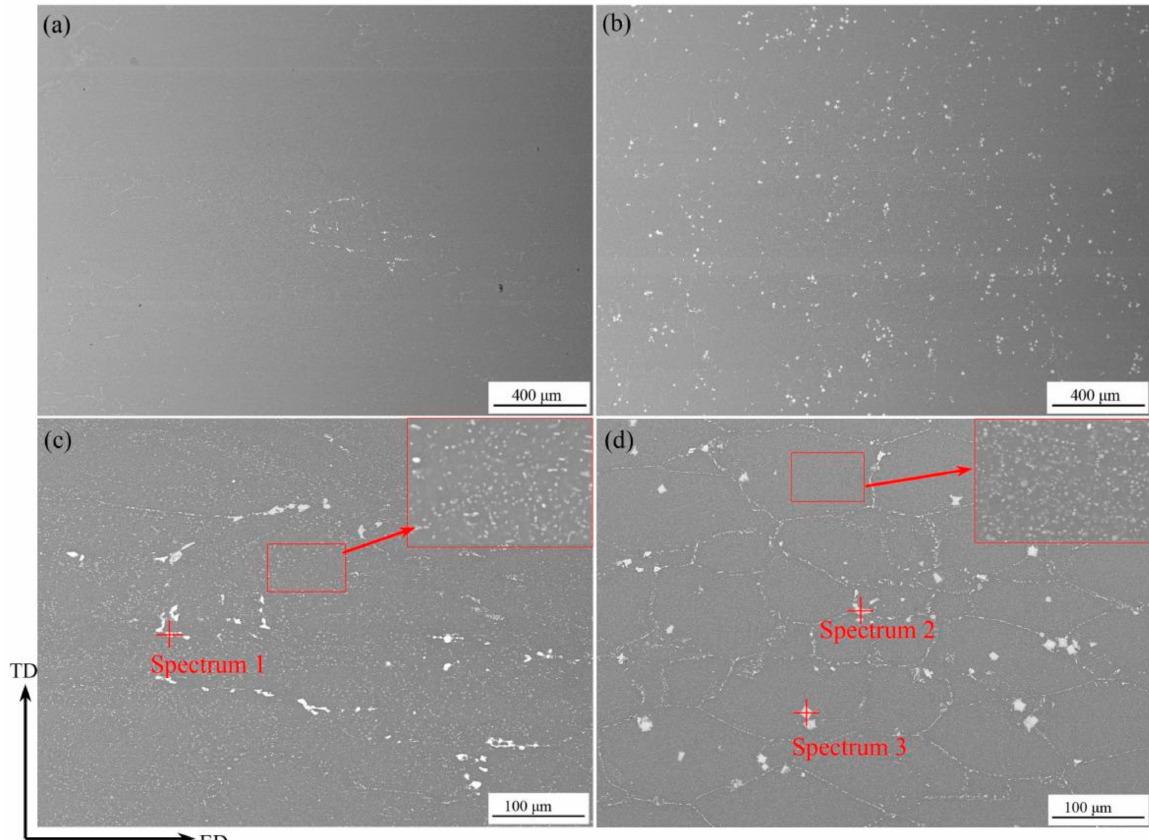
Figure 3. BSE images of secondary phases of Al-Zn-Mg-Cu-Zr alloy ( a , c ) and Al-Zn-Mg-Cu-Sc-Zr alloy ( b , d ) in the hot-extrusion condition.